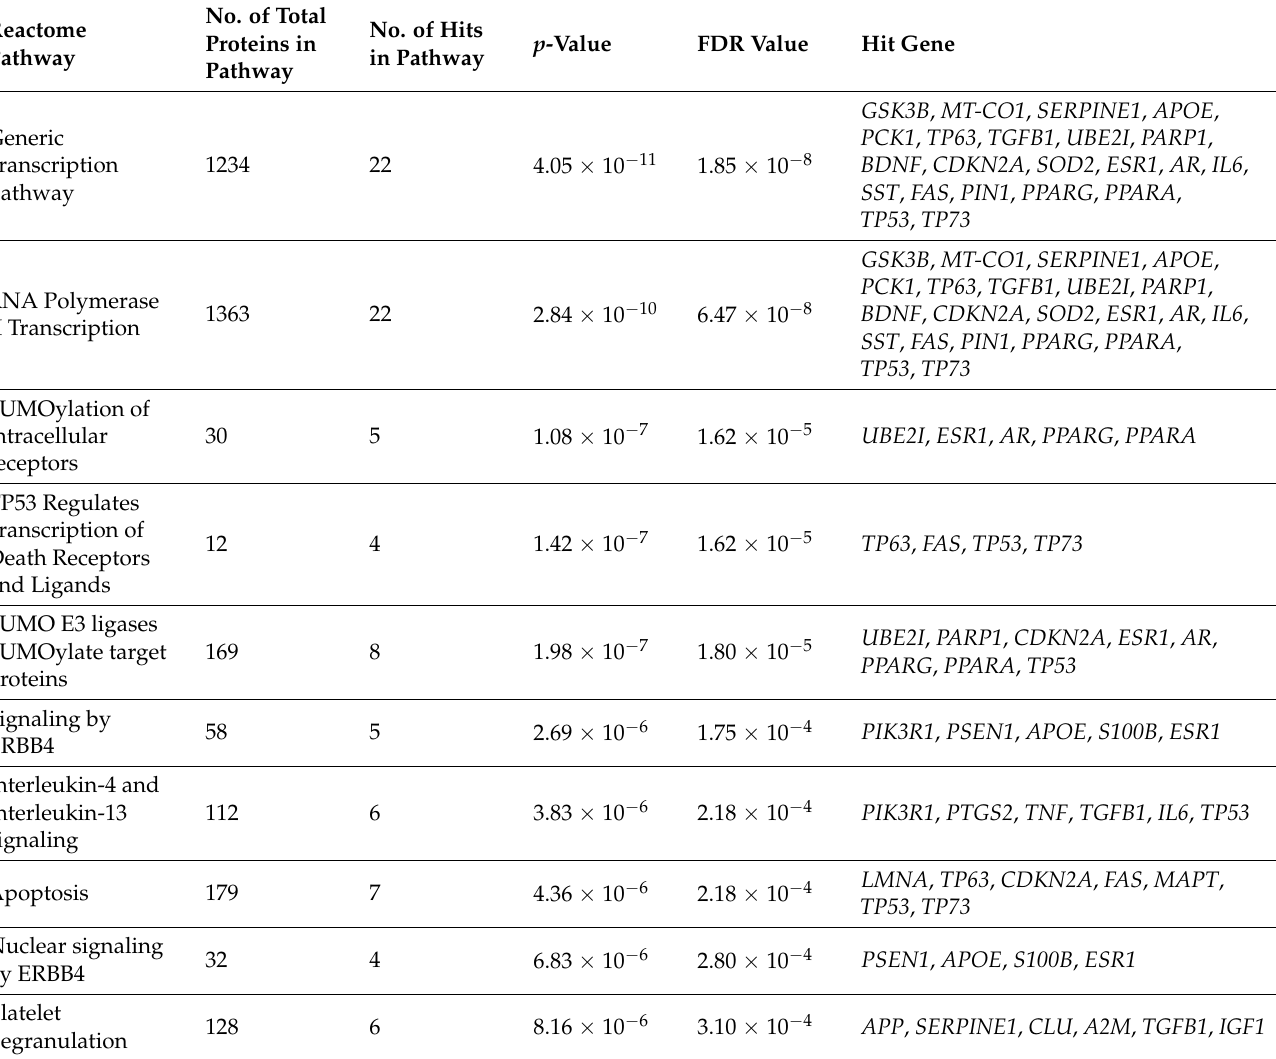
Table 5. Reactome pathway enrichment analysis results—AD–AR overlap